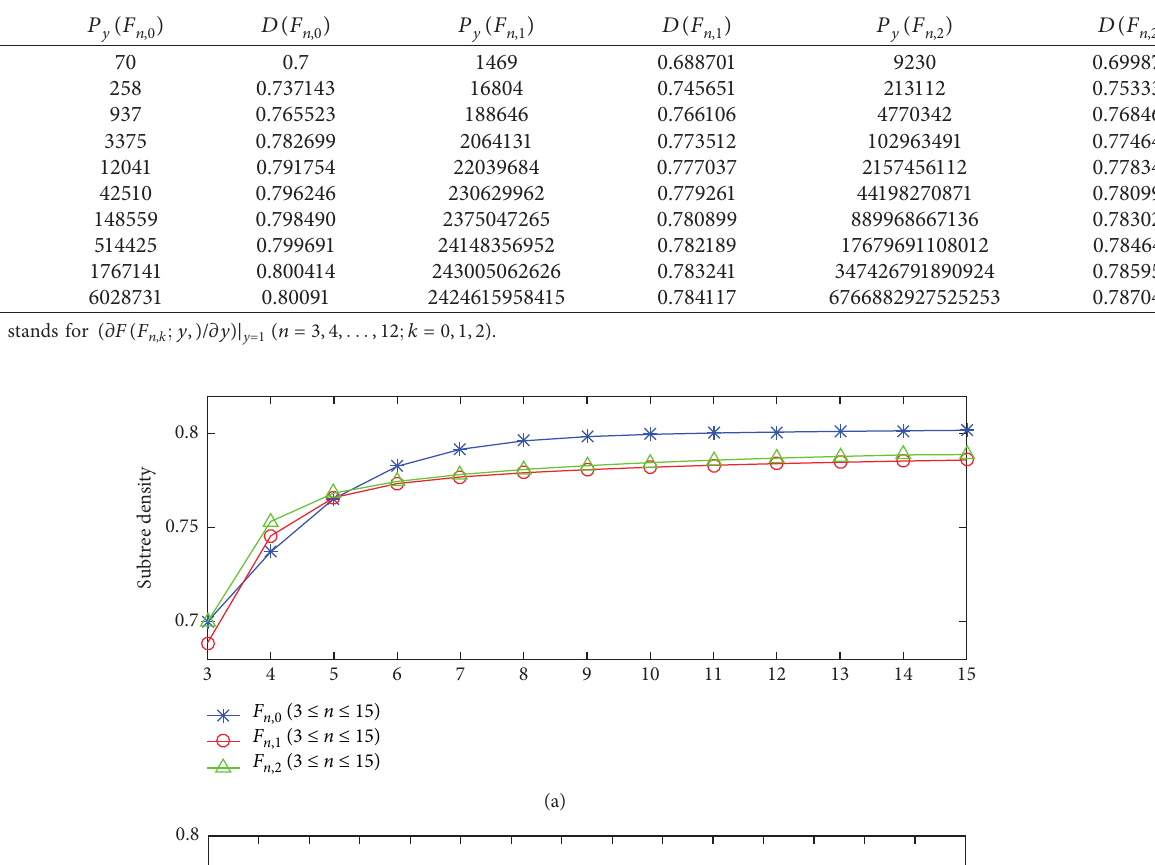
( n � 3 , 4 , ... , 15 ; k � 0 , 1 , 2 ) . n,k